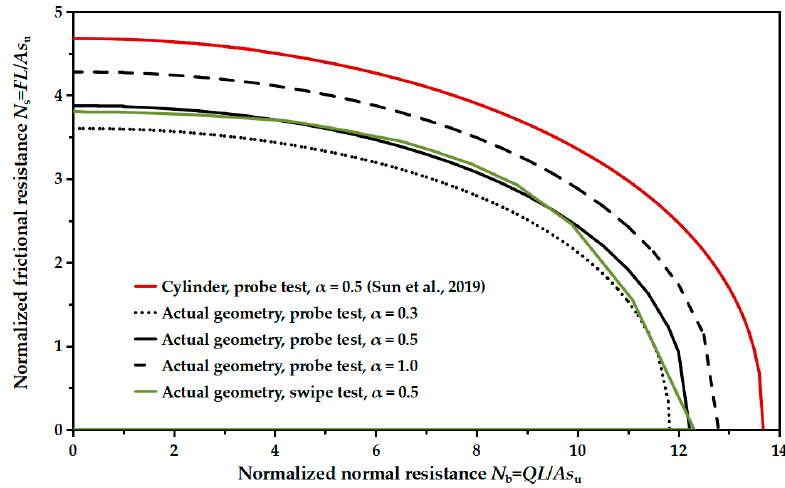
Figure 9. Comparison of envelopes of two types of chain obtained by the swipe test and probe test. Compared with